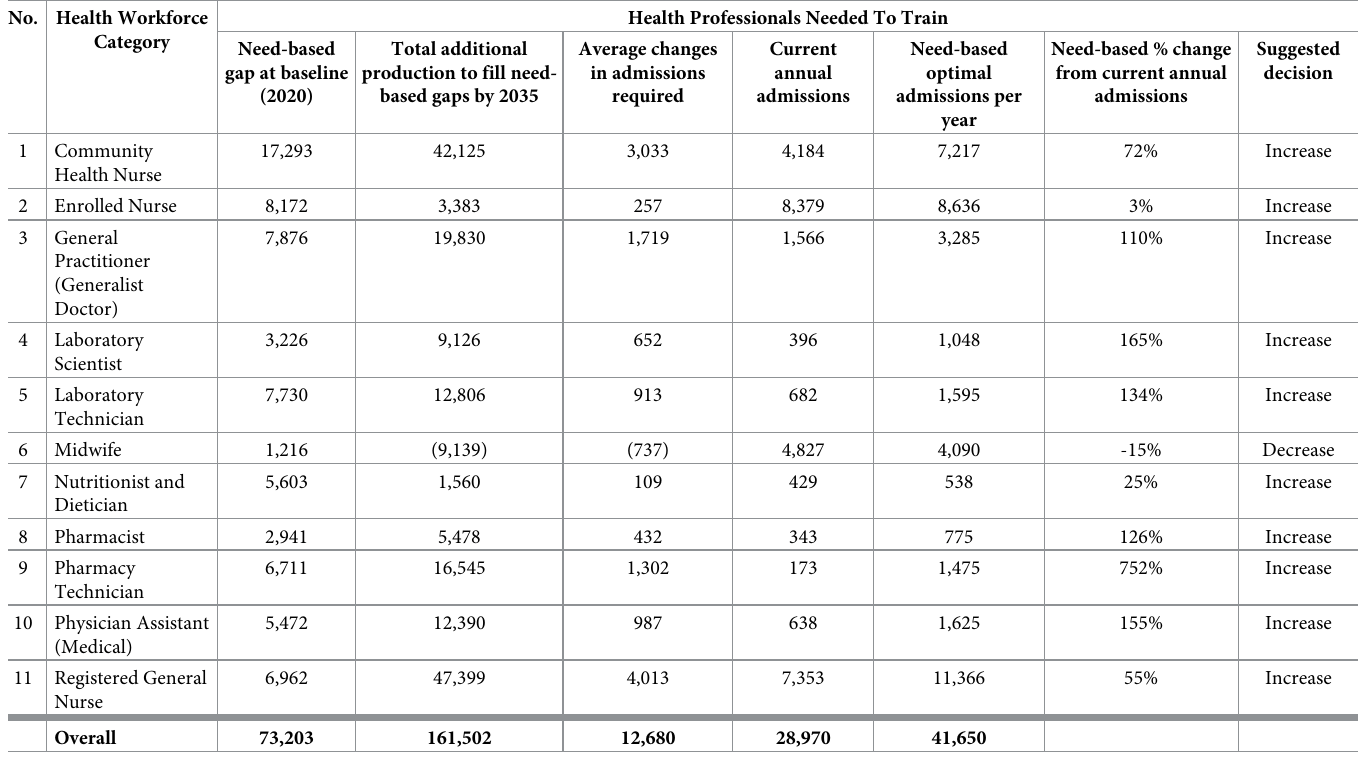
Table 5. Need-based health professions training